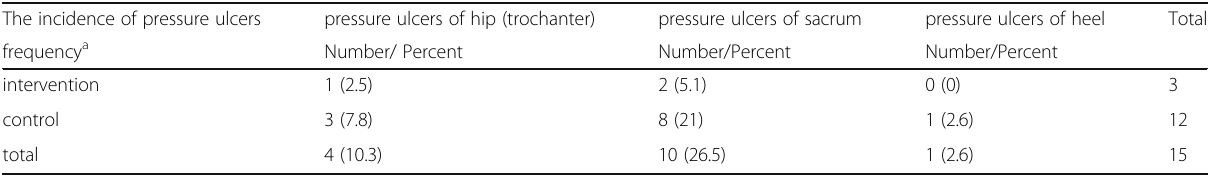
Table 4 Frequency of pressure ulcers in the areas under study The incidence of pressure ulcers